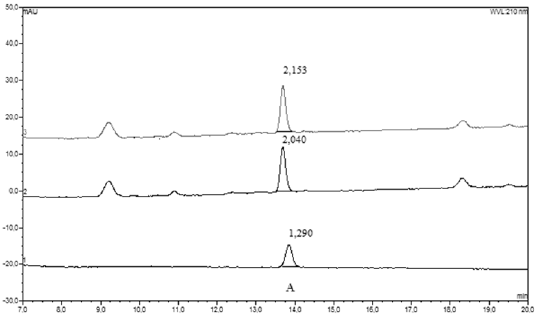
Figure 2. Chromatogram HPLC–UV-Vis. Double chromatographic analysis (HPLC-UV-Vis) of cerebrospinal fluid sample obtained from patient No 9 (Supplementary Materials Table S5). The bottom chromatogram illustrates the elution of standards: A—3-hydroxyphenyl acetic acid. Numbers over the peaks represent their area.